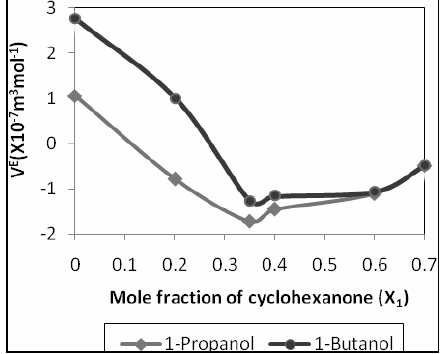
Figure 4. Variation of excess internal pressure versus mole fraction of cyclohexanone (X ). 1